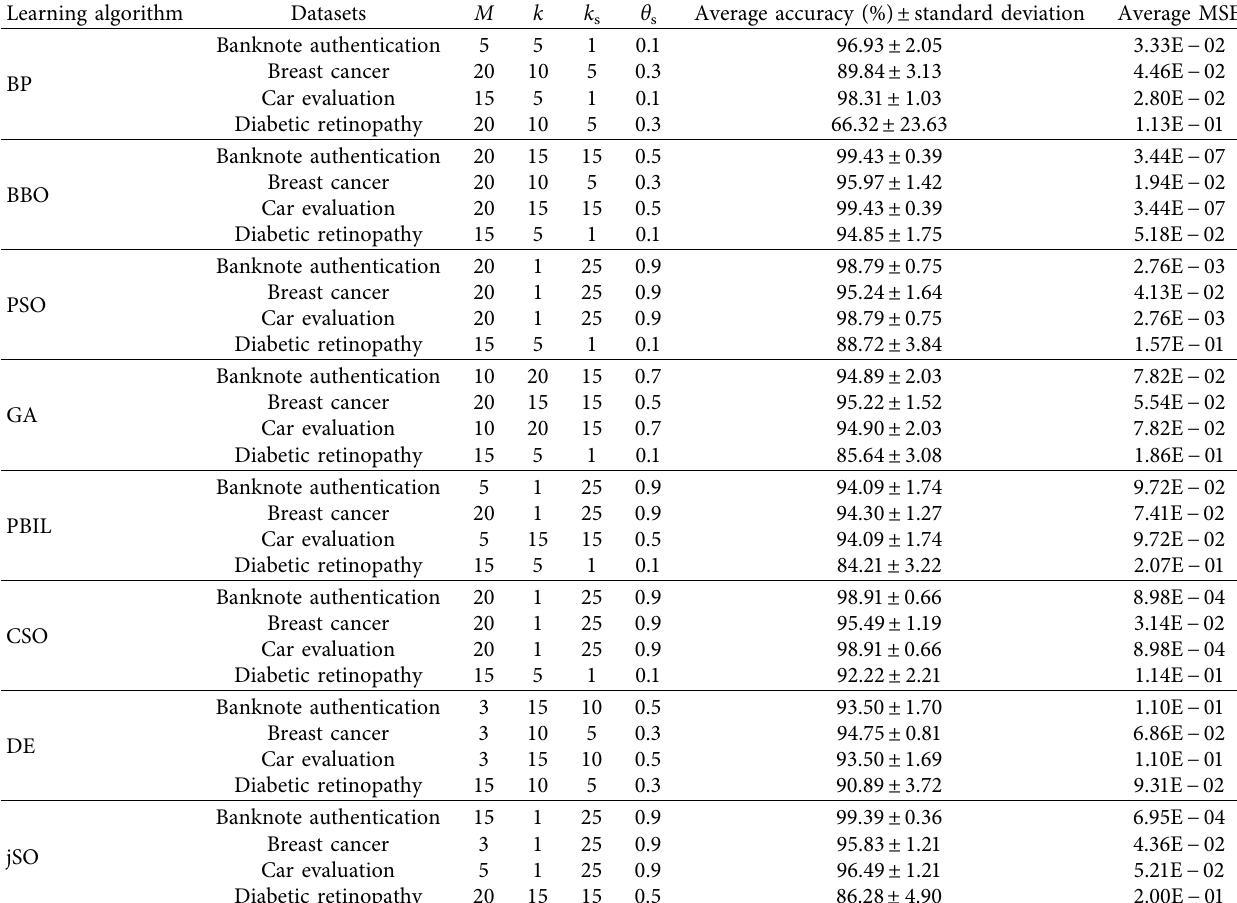
Table 8: Average accuracy, standard deviation, average MSE, and corresponding optimal parameters of each learning algorithm in different datasets. Learning